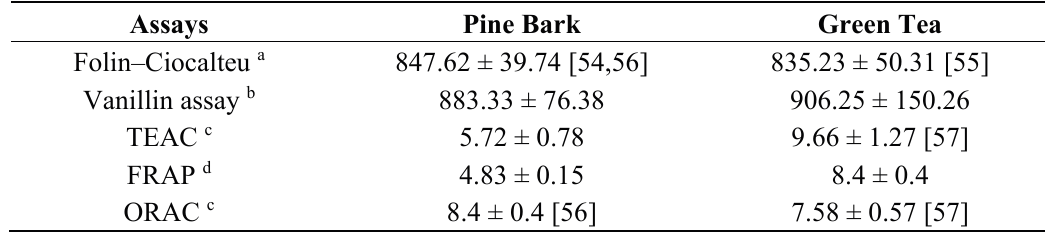
Table 3. Values for different antioxidant measurements performed with pine bark and green tea extracts. Values are expressed as the mean ±